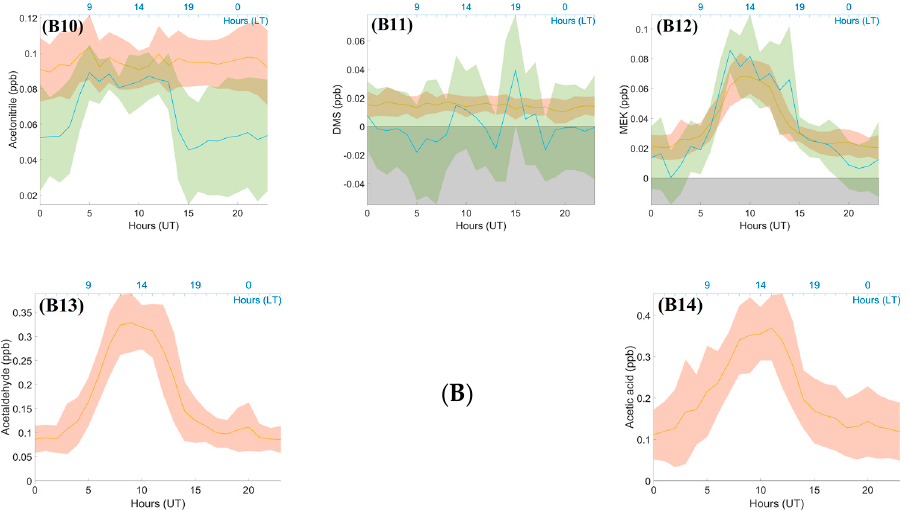
Figure 6. ( A ) Diurnal variation in gases (NO x and O 3 ), temperature, solar radiation parameters, and wind speed with their standard deviation (1 σ ) and wind direction at Maïdo and Bélouve for each hour. ( A1 ) Solar Radiation (W m -2 ), ( A2 ) Temperature (°C), ( A3 ) PAR (µmol m - ² s -1 ), ( A4 ) Maïdo Wind Direction (°), ( A5 ) Wind Speed (m s -1 ), ( A6 ) Bélouve Wind Direction (°) ( A7 ) Nitrogen oxides (NO x , ppb), ( A8 ) ozone (O 3 , ppb). ( B ) Diurnal variations in different VOCs and their standard deviation (1 σ ), measured by the BIRA PTR-MS at Maïdo and LSCE PTR-MS at Bélouve, except for formaldehyde data, which were measured by the Aerolaser (AL 4021 model; Garmisch-Partenkirchen, Germany) (from 12 March to 19 April for the Maïdo observatory and 25 April to 2 May for Bélouve). Green, Bélouve measurements; red, Maïdo measurements for the same period from 25 April to the 2 May 2018. No data were obtained for acetic acid, acetaldehyde, and xylenes at Bélouve. ( B1 ) isoprene (ppb), ( B2 ) Methacrolein + Methyl Vinyl Ketone (MARC +MVK, ppb), ( B3 ) Monoterpenes (ppb), ( B4 ) Methanol (ppb), ( B5 ) Acetone (ppb), ( B6 ) Formaldehyde (HCHO, ppb), ( B7 ) Toluene (ppb), ( B8 ) Xylenes (ppb), ( B9 ) Benzene (ppb), ( B10 ) Acetonitrile (ppb), ( B11 ) Dimethyl Sulfide (ppb), ( B12 ) Methyl Ethyl Ketone (MEK), ( B13 ) Acetaldehyde (ppb), ( B14 ) Acetic acid (ppb).